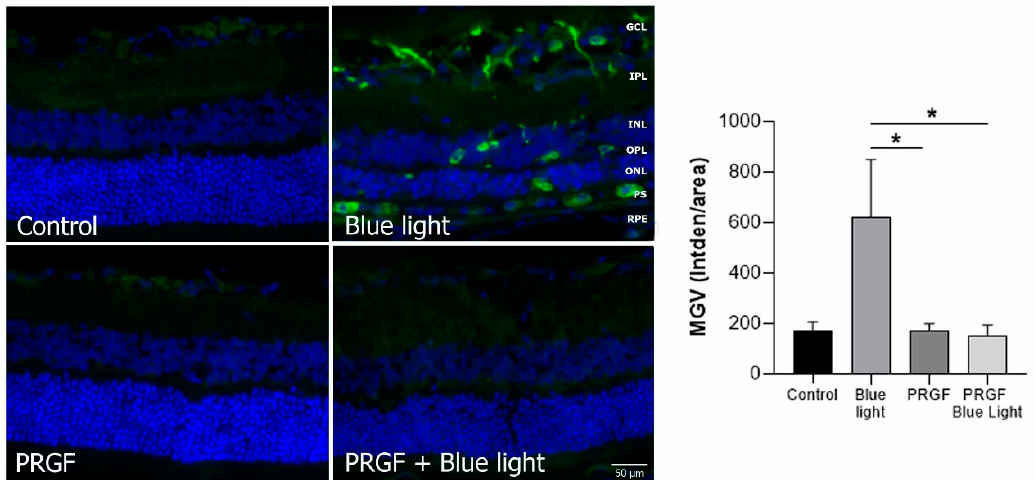
Figure 7. Immunofluorescence for HO-1 (green) and DAPI (blue) in transversal section of retinas ( n = 4). The results showed that the expression of HO-1 was increased by blue light compared to PRGF treatment conditions. Differences between control and blue light were also detected; however, statistical analysis did not show significance ( p = 0.0578). Statistical analysis: one-way ANOVA, * p < 0.05. Scale = 50 µm.